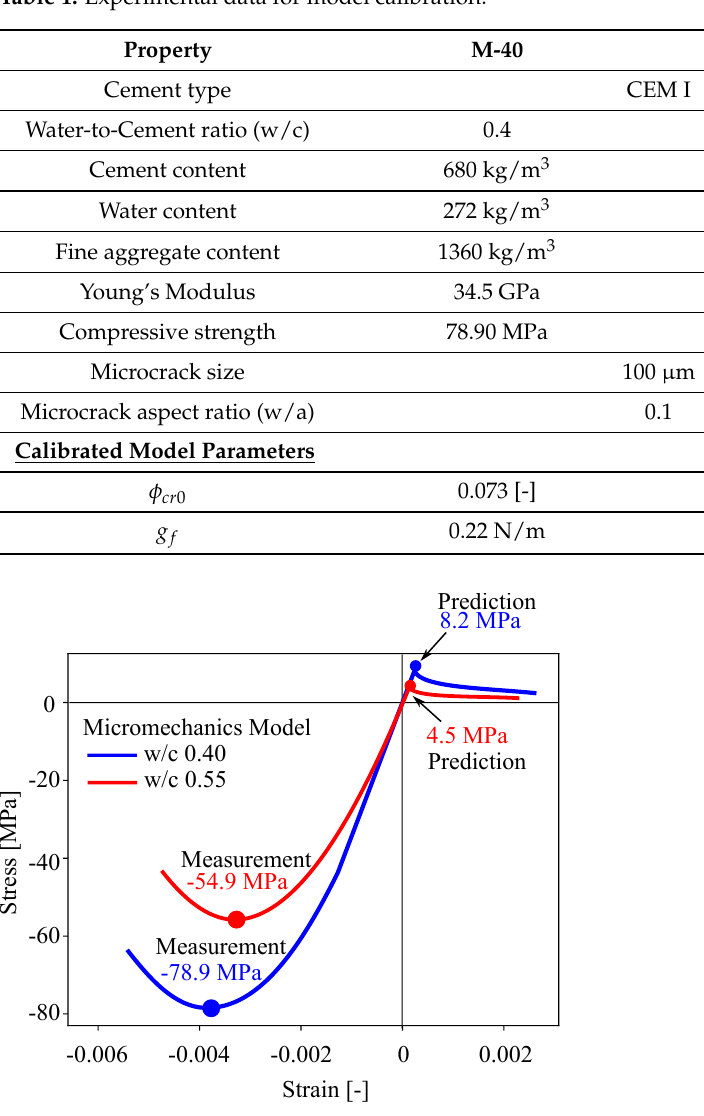
Table 1. Experimental data for model calibration.